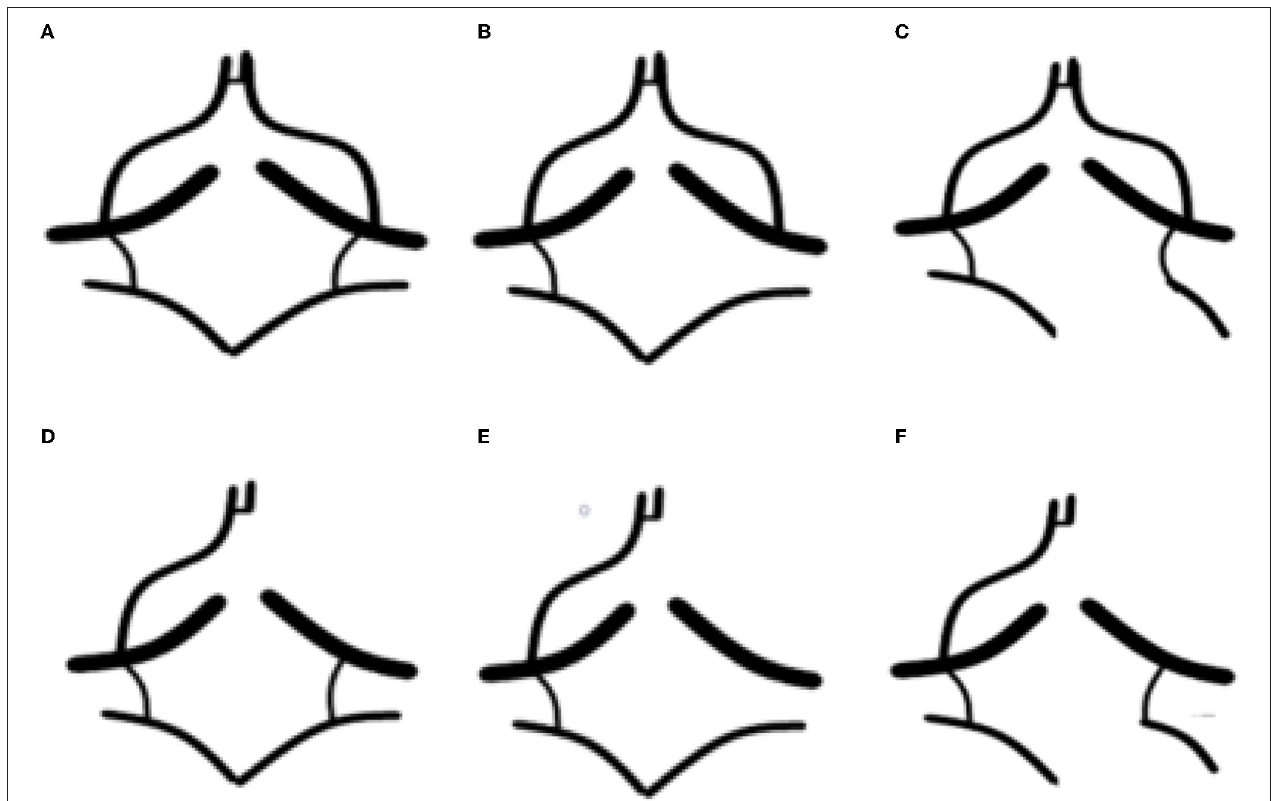
FIGURE 3 | The morphology variants of the circle of Willis in a patient with severe stenosis of left ICA. (A) Complete circle of Willis (type I); (B) no ipsilateral posterior communicating artery (PCoA) (type II); (C) ipsilateral fetal-type posterior cerebral artery (FTP) (type II); (D) no ipsilateral in the first segment of the anterior cerebral artery (ACA-A1) (type III); (E) no ipsilateral PCoA and incomplete anterior circulation (type IV); and (F) ipsilateral fetal-type posterior (FTP) and incomplete anterior circulation (type